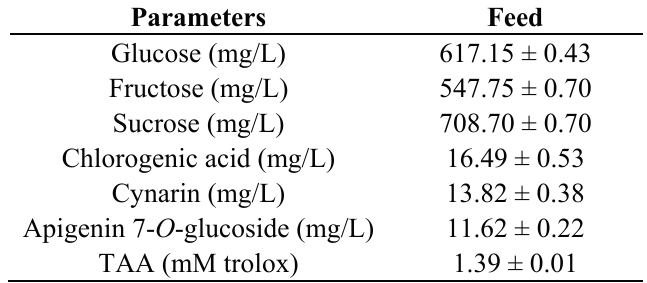
Table 3. Chemical composition of the feed solution for Desal DK membrane.